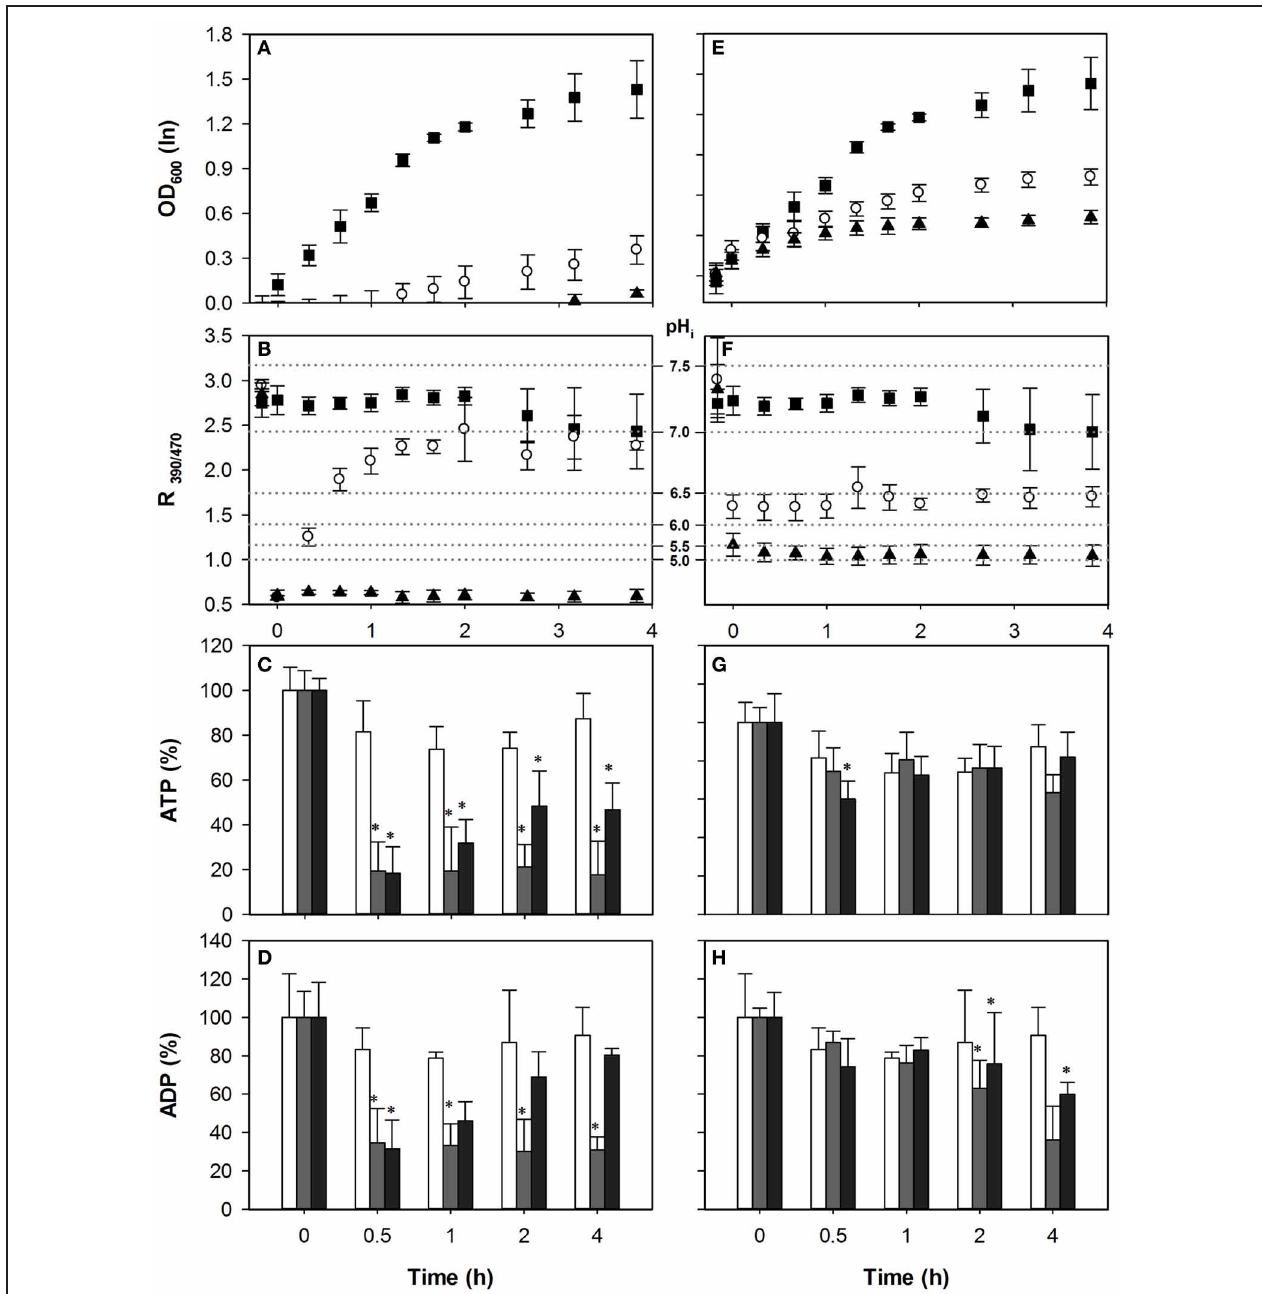
excitation at 390nm and 470nm (R 390 / 470 ) while the relevant pH i values derived from the calibration curves are also indicated. Data presented are the average of three independent cultivations and error bars represents standard deviation. An asterisk indicates significance of the difference between acid exposed and control cultures at similar time point (two-tailed t -test; P < 0 .